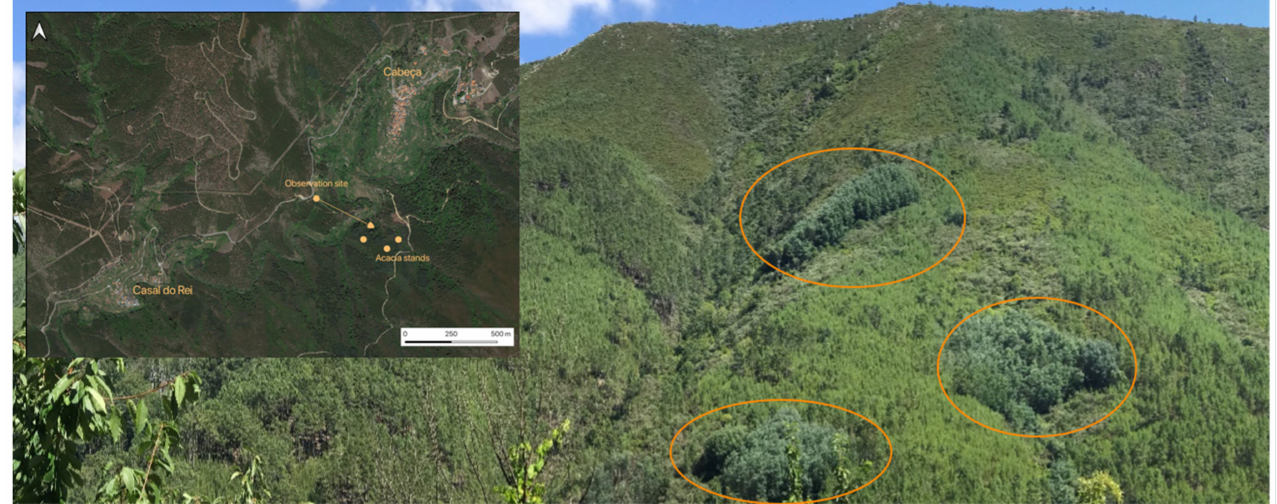
Figure 4. A. dealbata stands (highlighted) on the opposite slope to the road that connects Casal do Rei to